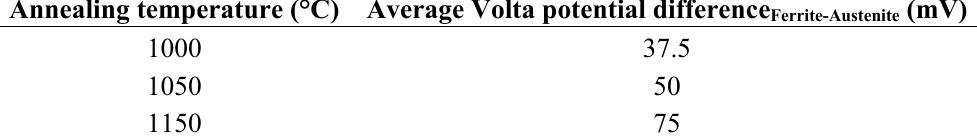
Table 4. The Volta potential difference between ferrite and austenite phase for the specimens annealed at 1000, 1050, and 1150